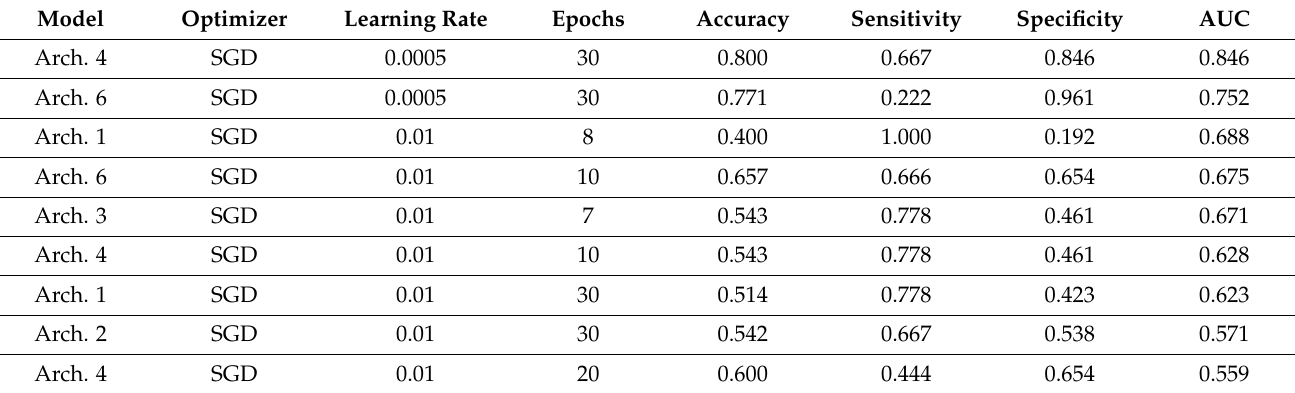
Table 7. EGFR mutation best results on Test dataset,